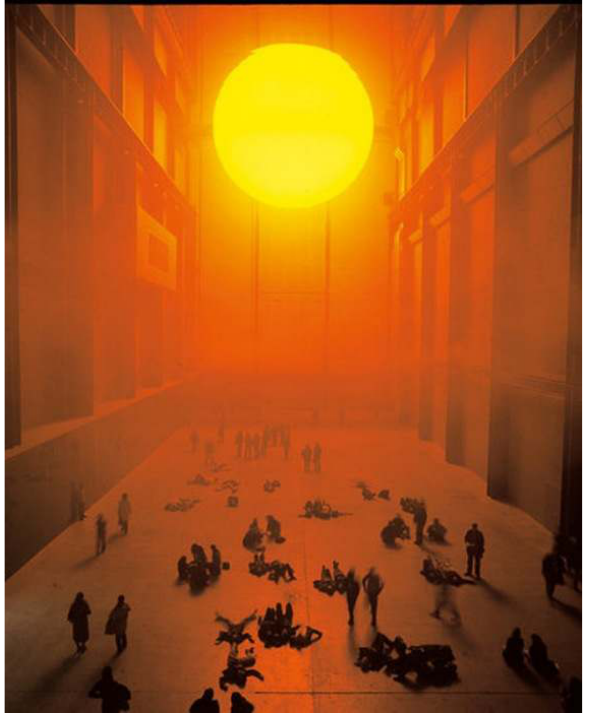
Installation view, Turbine Hall at Tate